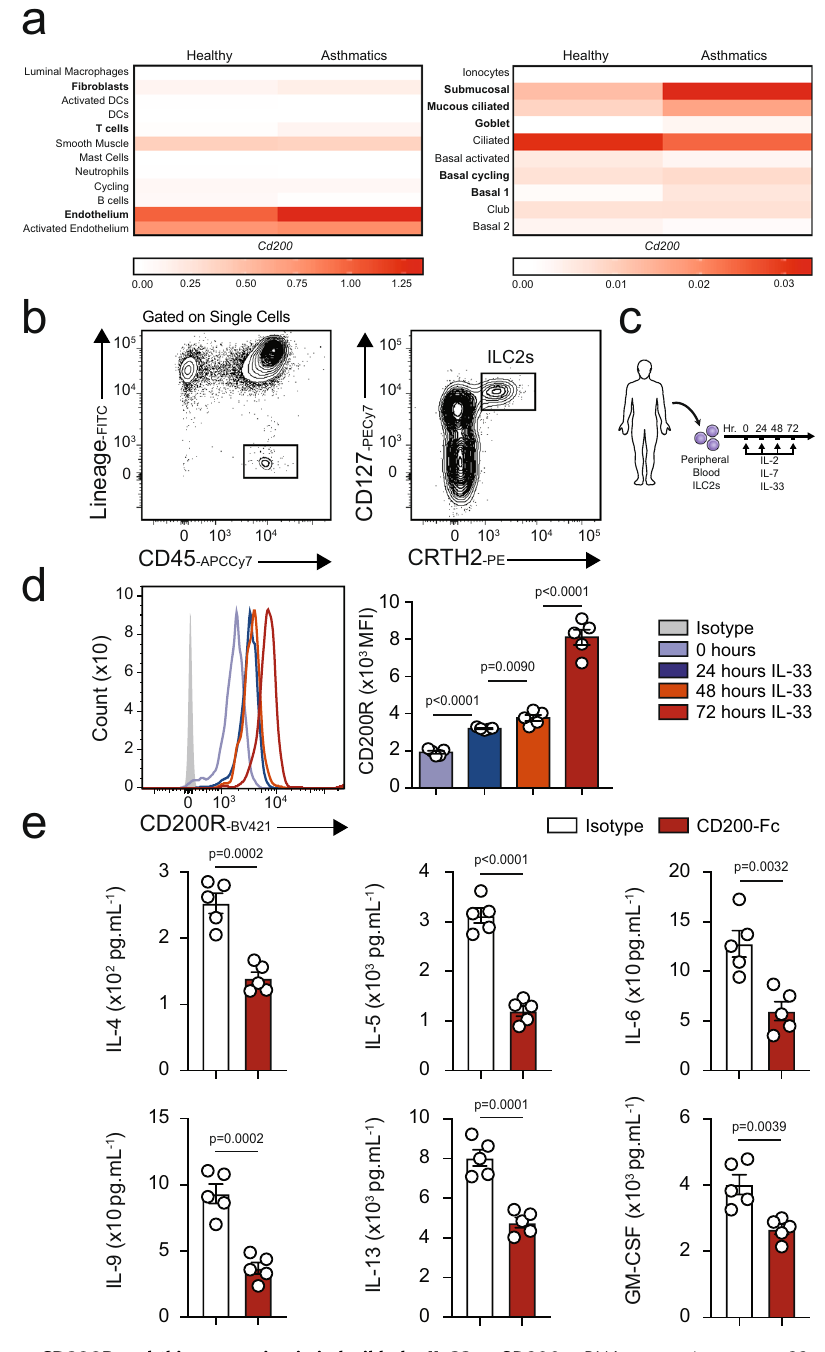
Fig. 6 Human ILC2s express CD200R and this expression is inducible by IL-33. a CD200 mRNA expression among 22 cell types in lungs of healthy donors and asthmatic patients. b The gating strategy of human ILC2s identi fi ed as Lin − CD45 + CD127 + CRTH2 + cells. c Human peripheral-blood ILC2s were freshly sorted and cultured with 10 ng of recombinant human (rh)IL-2 and rhIL-7 in presence or absence of rhIL-33 (10 ng) for 24, 48, and 72 h. Freshly isolated ILC2 at 0 h and ex vivo activated ILC2s were analyzed by fl ow cytometry as indicated in the scheme. d kinetics of CD200R induction by IL-33. e The levels of IL-4, IL-5, IL-6, IL-9, IL-13, and GM-CSF in the culture supernatants were measured by Luminex after 48 h of stimulation with CD200-Fc (10 µ g/mL). Data representative of fi ve individual blood donors, n = 5. Error bars are the mean ± SEM. Statistical analysis, one-way ANOVA and